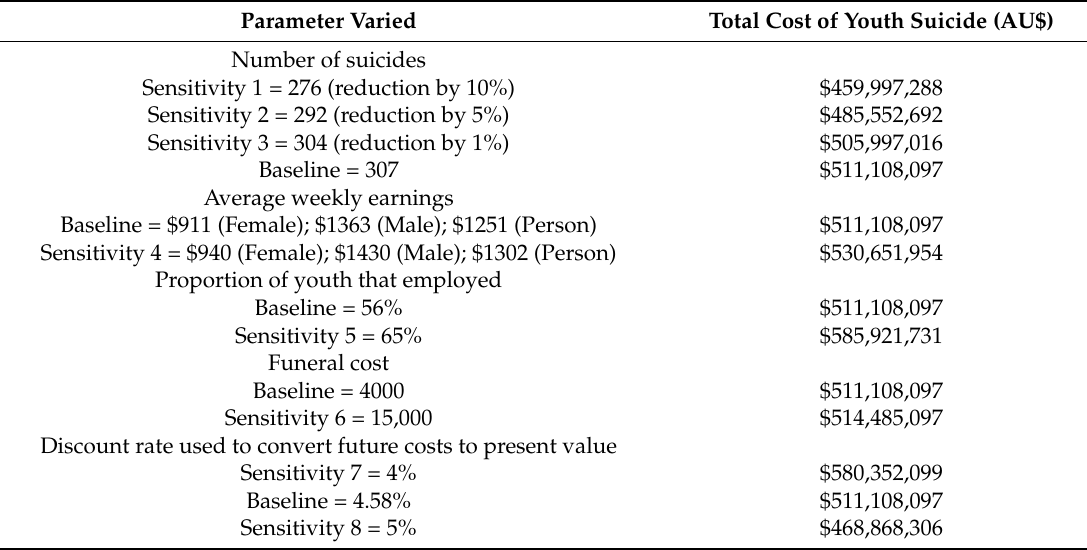
Table 6. Sensitivity analysis of key parameters (in